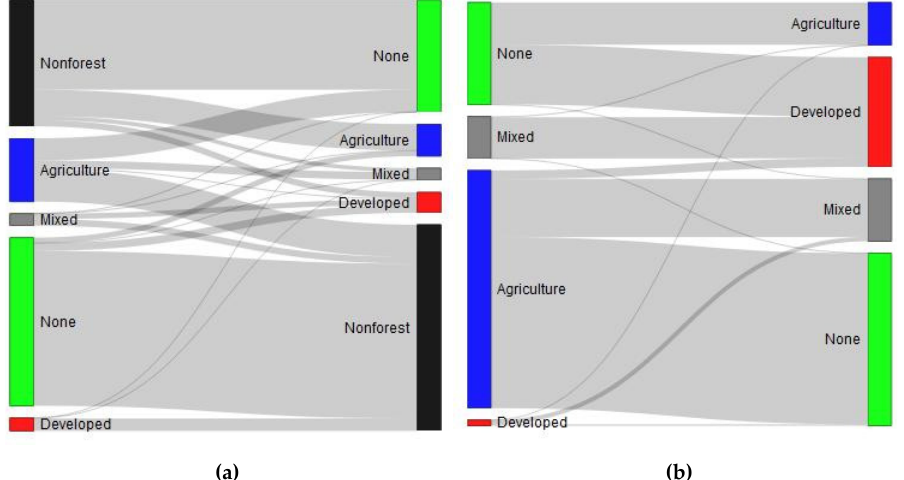
Figure 7. Flow diagrams of CONUS forest area change among interface classes and nonforest, showing ( a ) total change and ( b ) the subset of change attributable to the shifting mosaic. The total area of all changes was. 300,552 km 2 , and the total area of the shifting mosaic was 39,638 km 2 . Within each diagram, flow is from 2001 ( left ) to 2016 ( right ). Flows less than 5 km 2 are not shown. Interactive versions of the flow diagrams are contained in supplemental material.